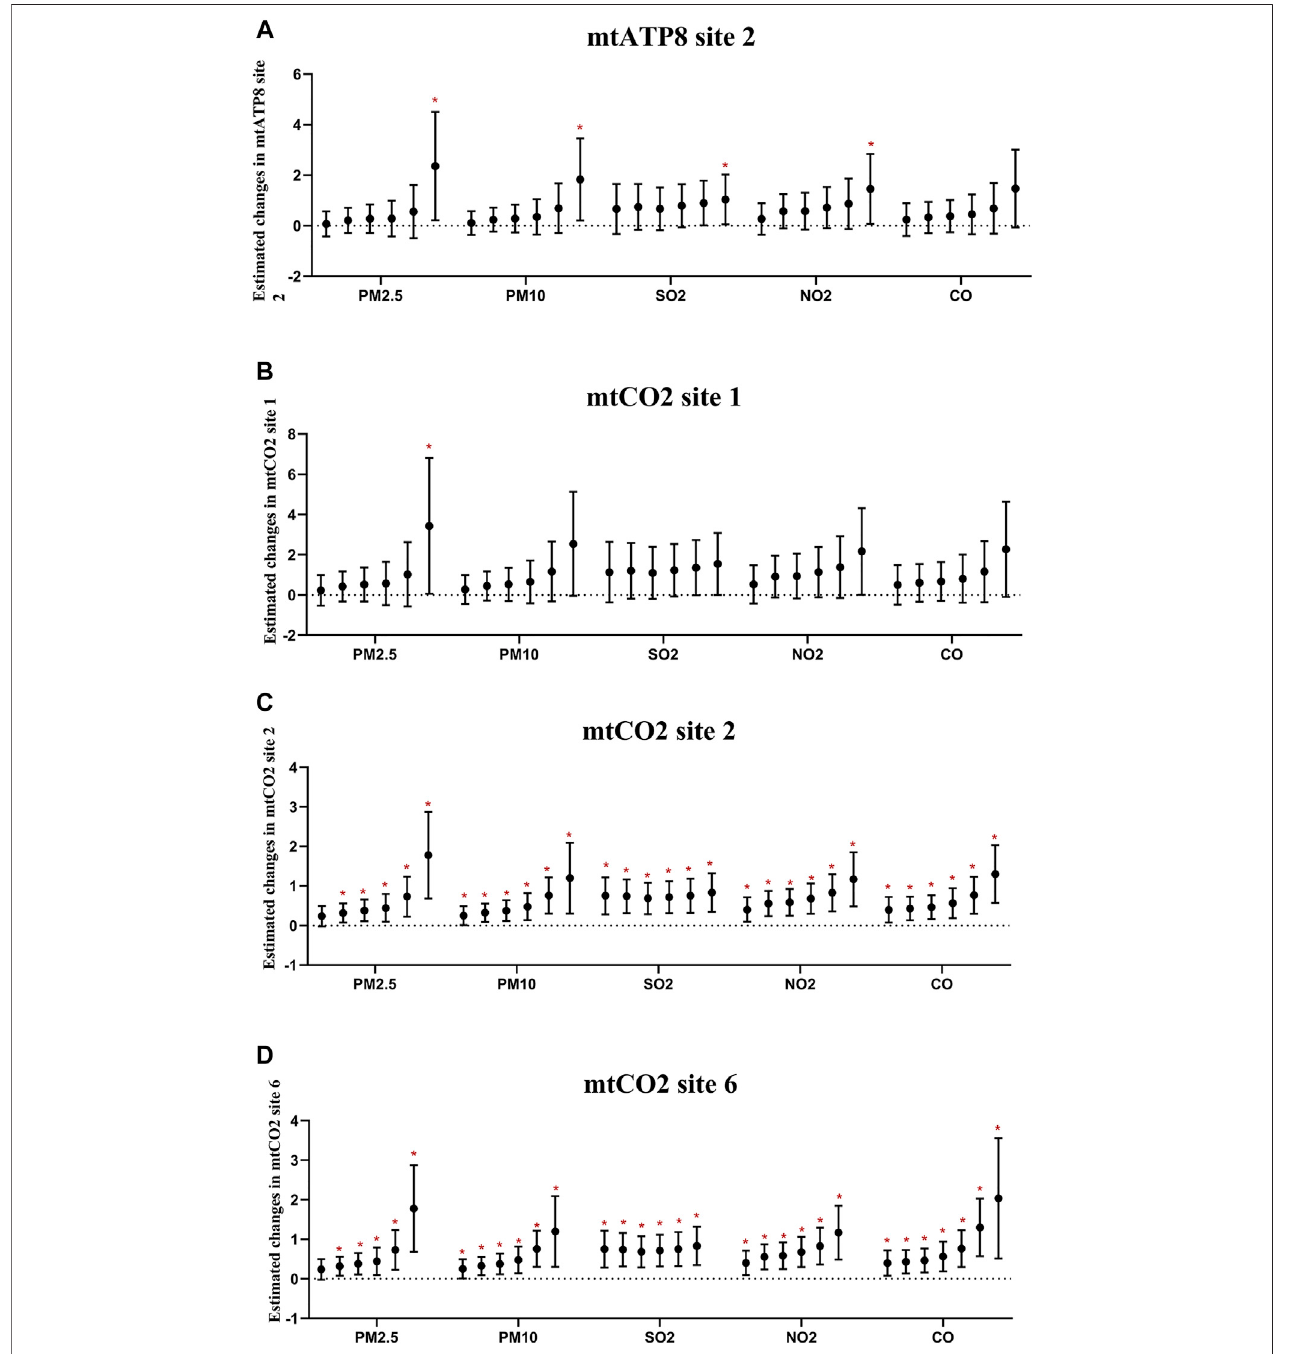
FIGURE 6 | Estimated changes (95% con fi dence intervals) of platelet mitochondrial DNA methylation in the thrombocyte parameters. Changes (95% con fi dence intervals) in the biomarkers with IQR increases in air pollution indicators were calculated, respectively, at different time lags (days). (A – D) Indicate the situation of each gene. In each pollutant group, the cumulative lag from the left to the right is 1 – 6